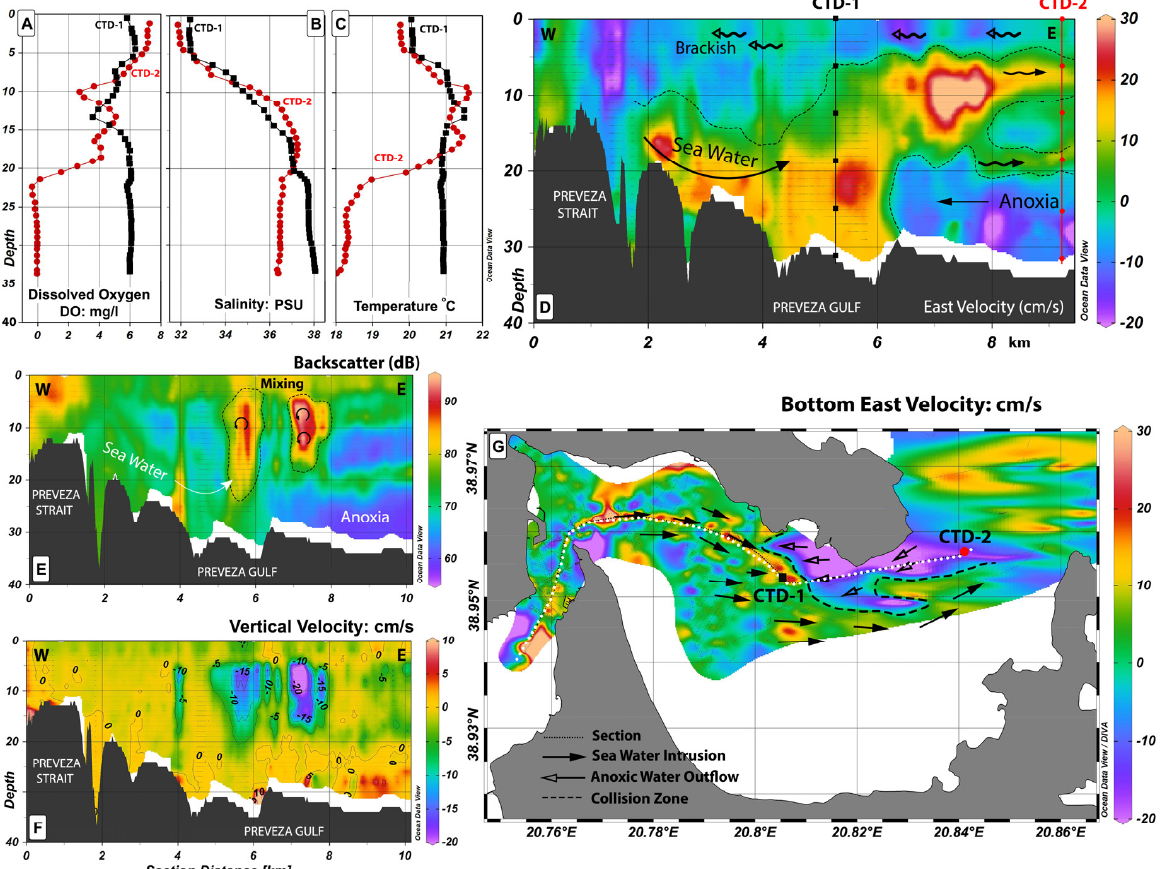
Figure 4. ( A – C ) CTD-1,-2 profiles (dissolved oxygen, salinity, temperature) at Preveza Gulf in November, ( D ) ADCP section showing the eastern velocity and the two selected CTD profile locations, ( E ) backscatter intensity section of the water column, ( F ) vertical velocity section, and ( G ) bottom eastern velocity (cm/s), CTD-1,-2 acquired during the November 2016 survey, and bottom collision zone between the inflowing seawater with the outflowing anoxic